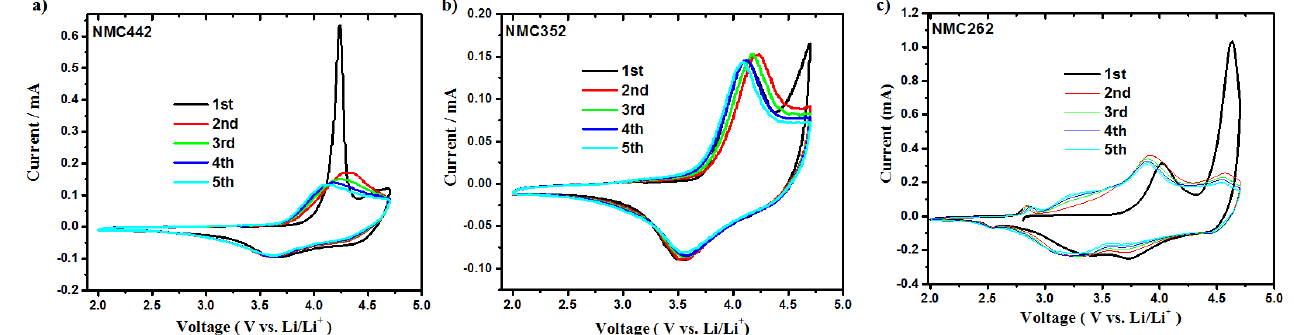
Figure 5. Cyclic voltammetry at the scan rate of 1 mV s − 1 for ( a ) NMC442, ( b ) NMC352; ( c ) NMC262.